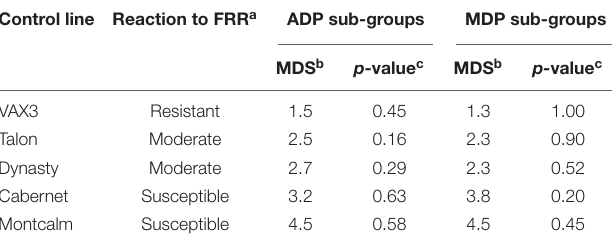
TABLE 1 | Fusarium root rot (FRR) mean disease severity (MDS) across two sub-group evaluations for the Andean Diversity Panel (ADP) and Middle American Diversity Panel (MDP).